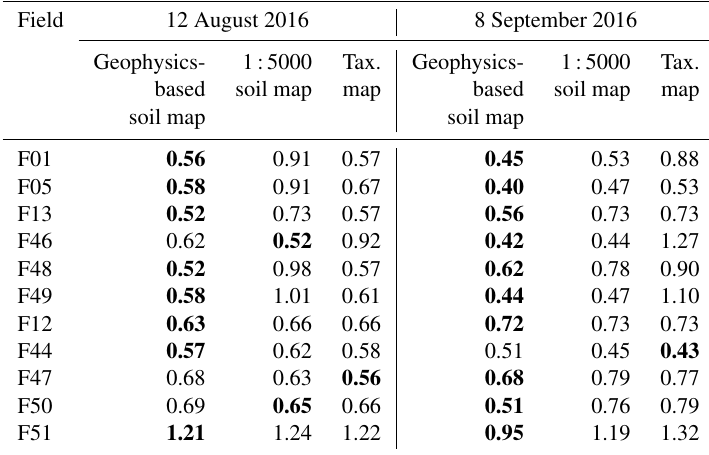
Table 5. RMSE between simulated LAI and LAI NDVI in fields with sugar beet. The best result for each date is marked in bold.